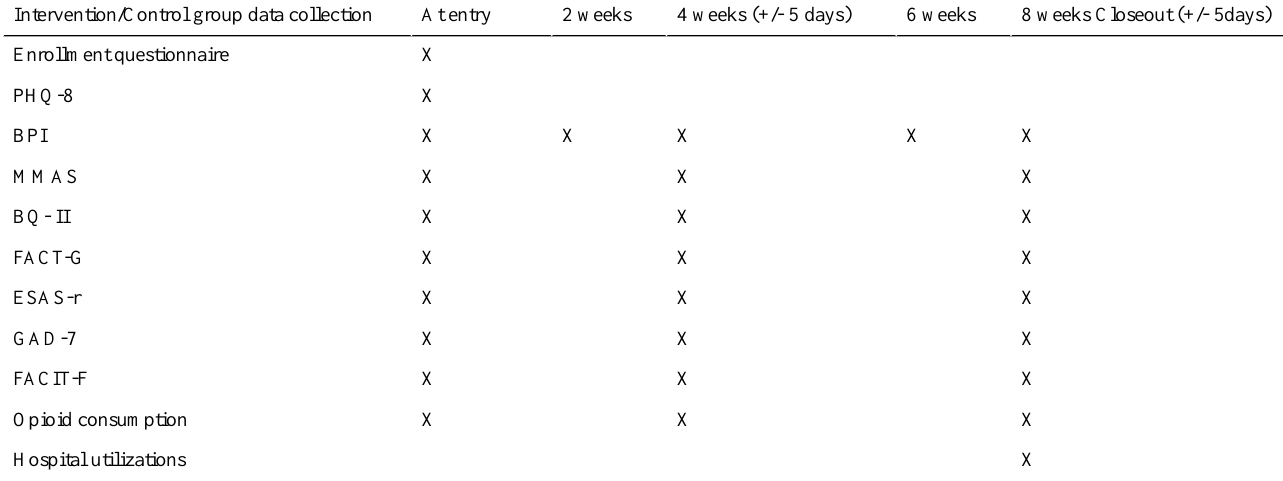
Table 1. Data collection schedule: the table depicts the schedule for data